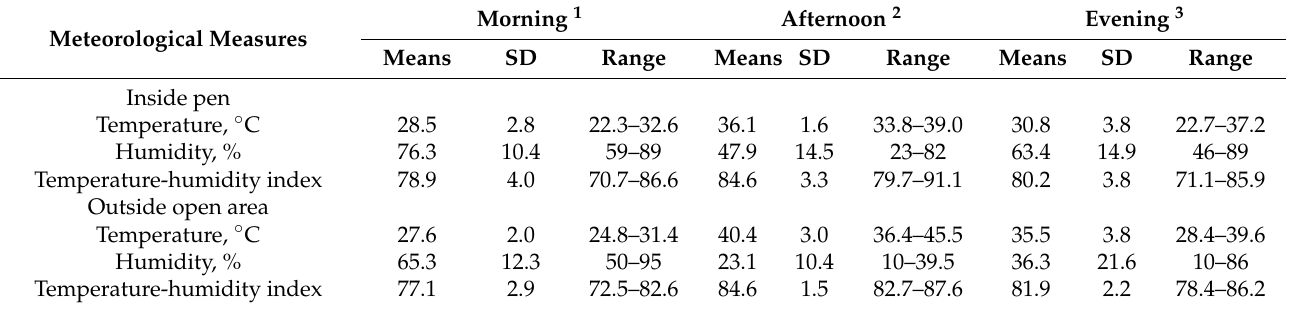
Table 3. Summary of morning and afternoon meteorological measures during the study period ( n = 146).